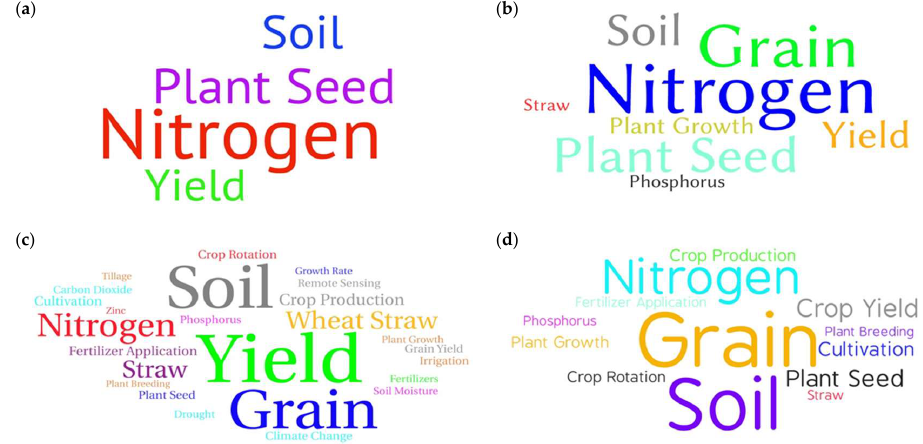
Figure 8. ( a – d ) Word cloud based on the main keywords related to agronomy in worldwide research until 1999 ( a , b ) and from 2000 ( c , d ) in wheat ( a , c ) and barley ( b , d ). For keywords clustered into the agronomy and genes and proteins thematic groups, Our analysis also showed a higher number of terms related to genetic and molecular topics in the period 2000–2018 compared to the earlier period (21 versus 14 in “wheat” documents; 30 versus 24 in “barley” documents). The finding that, at any period, barley is connected with more keywords from this group than wheat is likely attributable to two different factors: (i) much more varied scientific topics have interested wheat researchers, which is reflected in the many keywords listed in the Scopus database that are related to other scientific disciplines; and (ii) molecular and reverse genetic approaches are more straight-forward in barley compared to wheat [48]. Our results have clearly demonstrated the different timelines of the progression of knowledge on wheat and barley in the affected disciplines (i.e., genetics and molecular biology). Up to 1999, most keywords in wheat mainly referred to molecules involved in genetic processes and their structure (Figure 9a). By